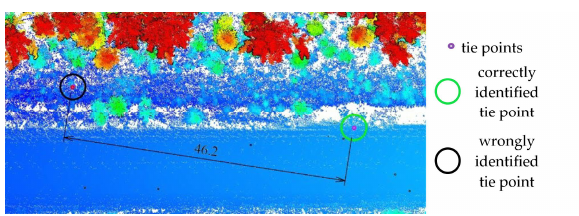
Figure 13 . Relative position of correctly and wrongly identified tie points.